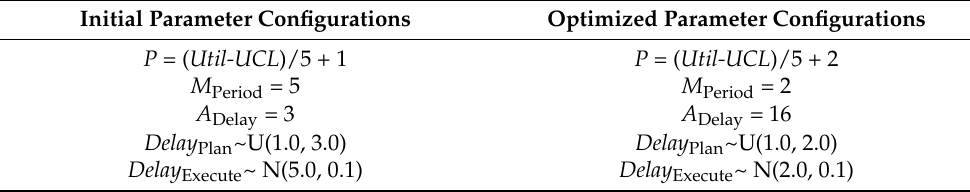
Figure 12. Time behavior analysis for the SUIS example. Table 2. Optimization of self-adaptation strategies and time